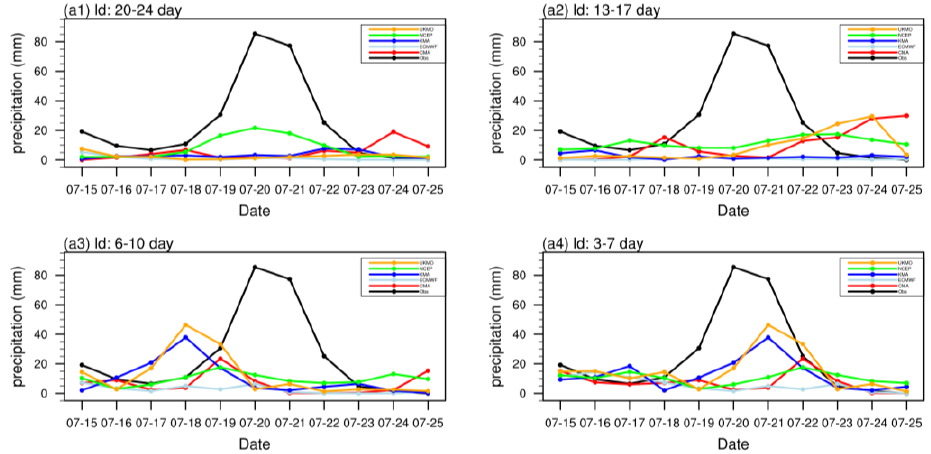
Figure 7. The daily average rainfall of Henan from 15 to 25 July and the predictions of the five models 20 days, 13 days, 6 days, and 3 days in advance, respectively ( a1 – a4 ).